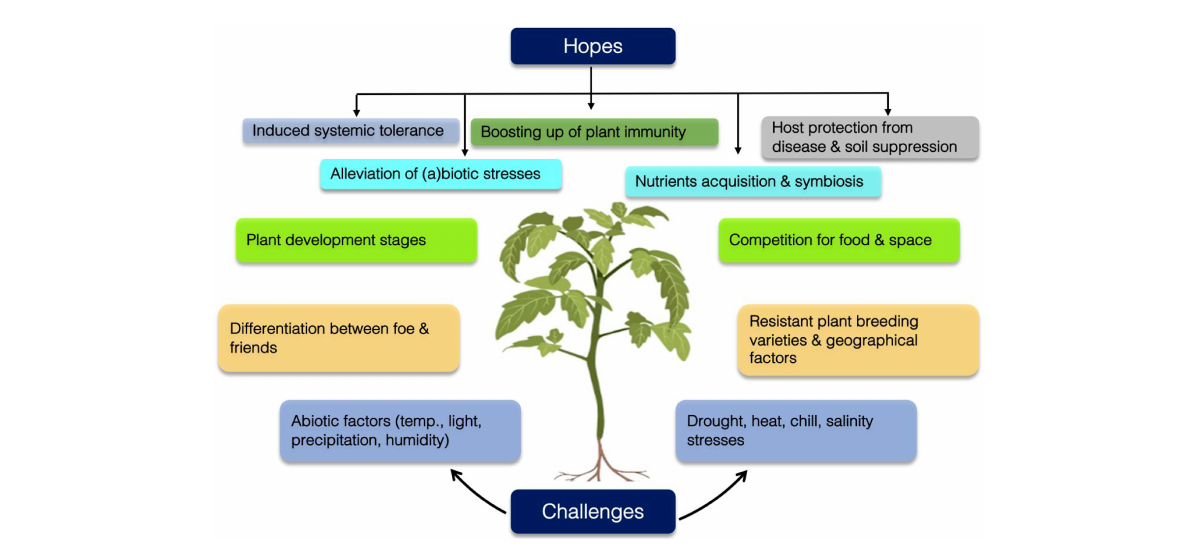
FIGURE3 Plant Microbiome provides key functions for plant health and its protection. Plant microbiome offers vital services for plant health. It facilitates biogeochemical cycling of plant nutrients, assist plant growth under biotic and abiotic conditions, induces systemic acquired resistance (SAR) and induces systemic resistance (ISR) in plant against plant pathogen. Inversely, Plant microbiome synchronously encounters biotic and abiotic stresses which are the substantial drivers that influence or alter microbiome diversity and